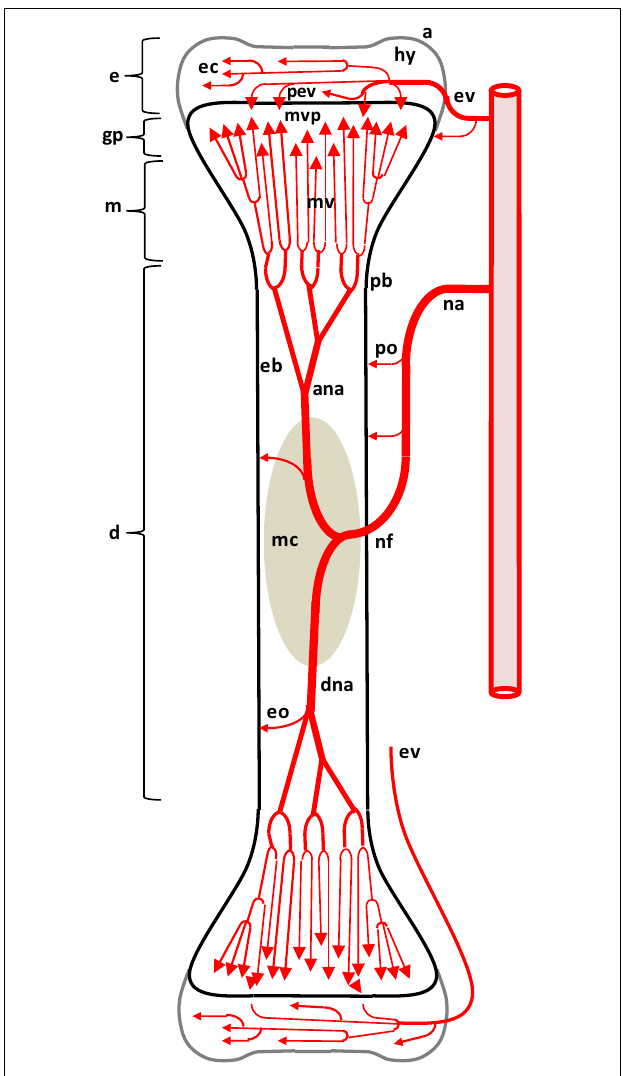
FIGURE 1 | Diagram depicting the arterial supply to a growing leg bone. The epiphyseal vascular supply (ev) courses through epiphyseal vascular canals (ec) within the hyaline zone (hy) of the epiphysis (e).Terminal branches of some ev form penetrating epiphyseal vessels (pev) that supply the epiphyseal side of the growth plate (gp) or physis.The nutrient artery (na) penetrates the diaphysis (d) at the nutrient foramen (nf) and divides into ascending and descending branches (ana, dna) that subdivide repeatedly to form metaphyseal vessels (mv) within the metaphysis (m).The mv supply the metaphyseal vascular plexus (mvp) on the metaphyseal side of the gp. Additional features include: a, articular zone of epiphyseal cartilage; eb, endosteal bone; eo, endosteal arterioles; mc, medullary cavity; pb, periosteal bone; po, periosteal arterioles. Micro-anatomical terminology is consistent with the established anatomical nomenclature for avian bones (Beaumont, 1967; Lutfi, 1970a,b;Wise and Jennings, 1973; Howlett,